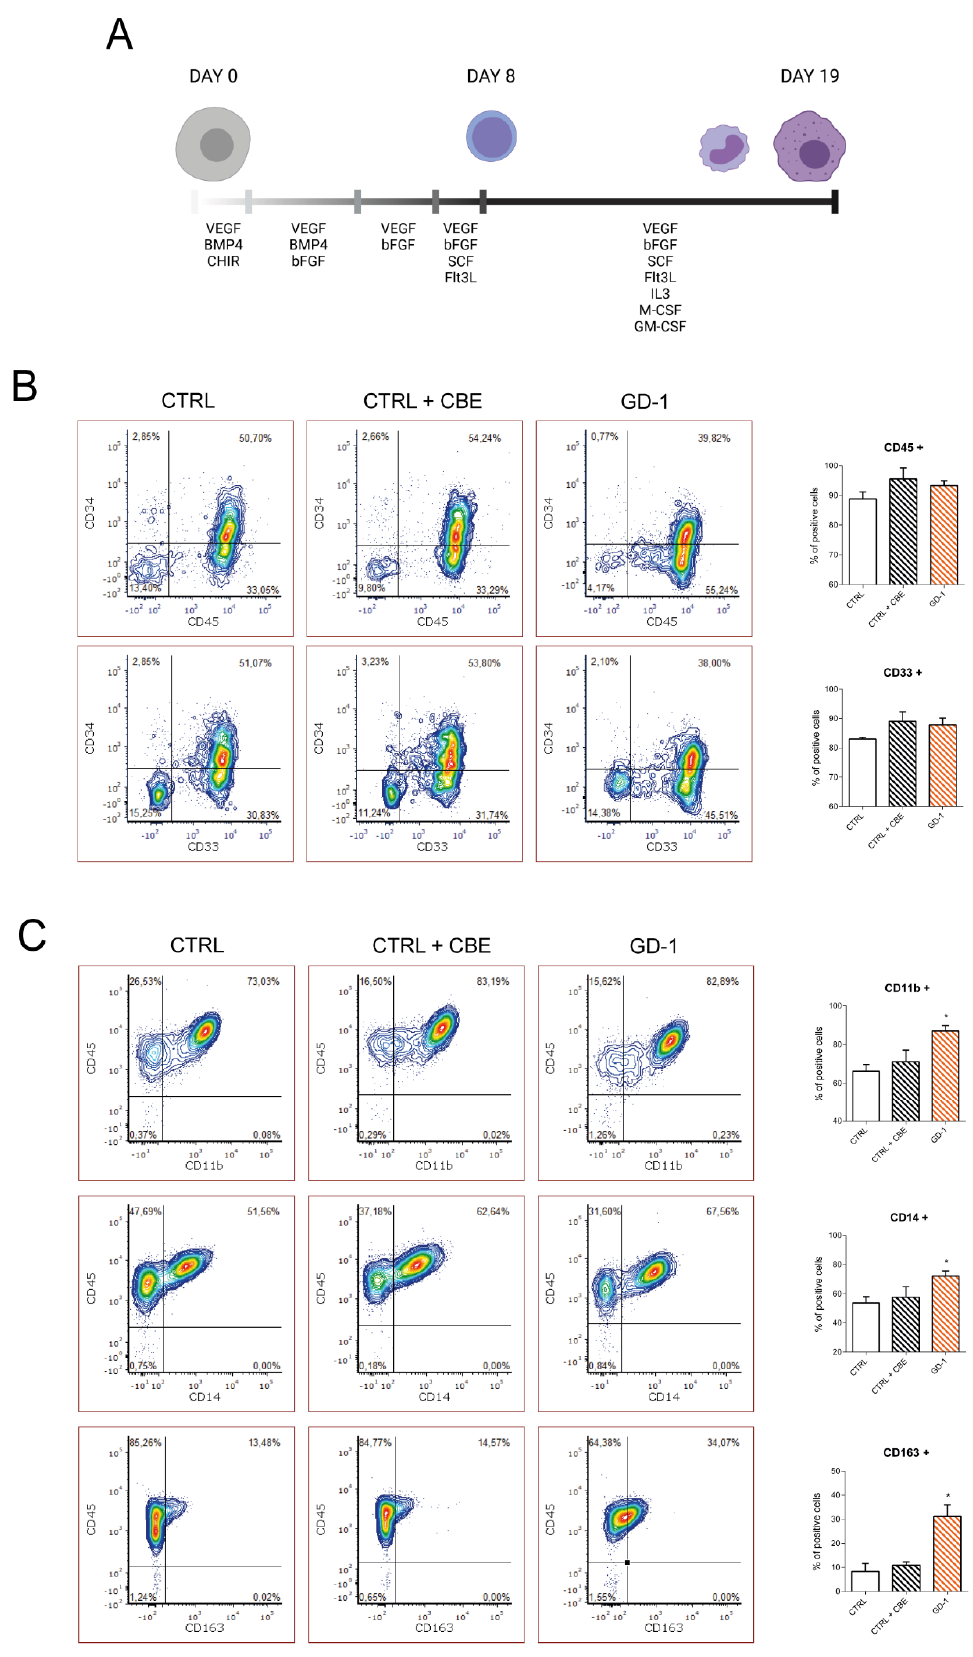
Figure 1. GD-iPSC efficiently differentiate into CD11b, CD14, CD163 monocyte/macrophages. ( A ) Schematic representation of the differentiation protocol used to obtain mature macrophages starting from iPSC going through the hematopoietic precursor stage. The main cytokines added